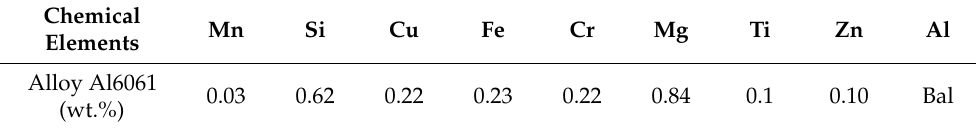
Table 1. Al6061 base material composition.